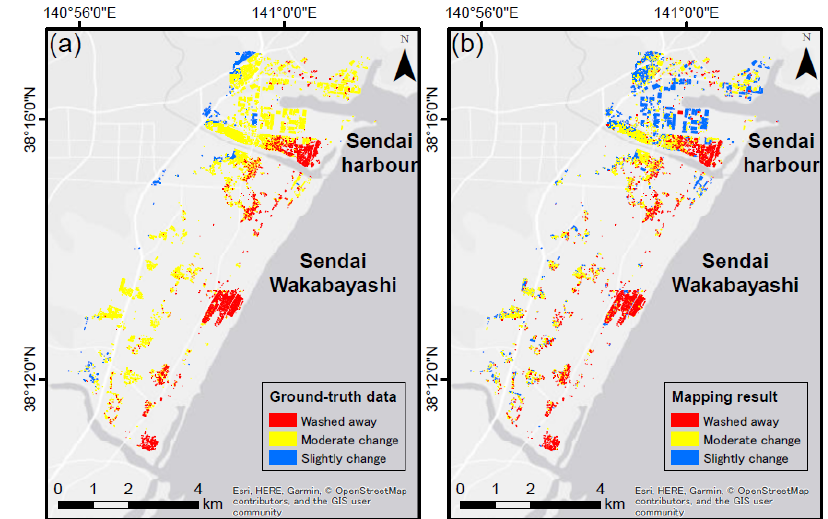
Figure 6. Visual results for Endo et al. SVM approach to map building damage. ( a ) Ground- truth; ( b ) mapping results. The image is from Endo et al. [10] and re-used with the corresponding author’s